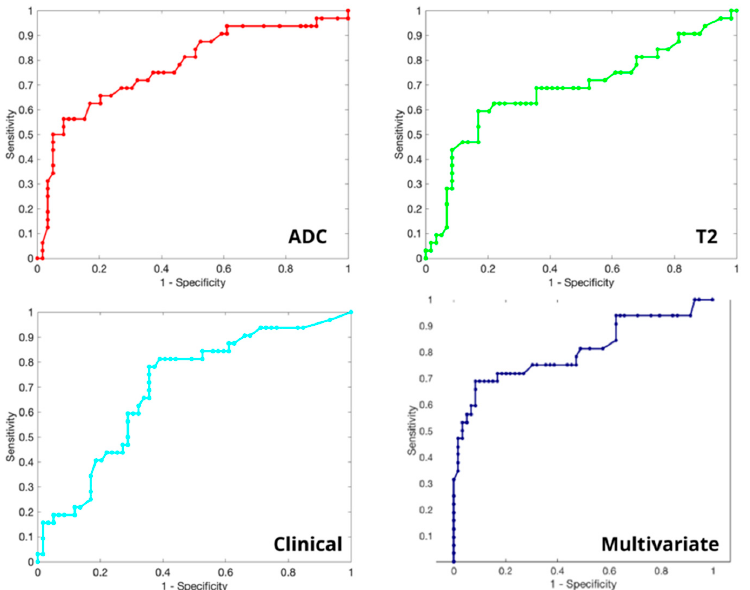
Figure 3. Receiver operating characteristic (ROC) curves of ADC WrapperRF (AUC = 0.774), T2